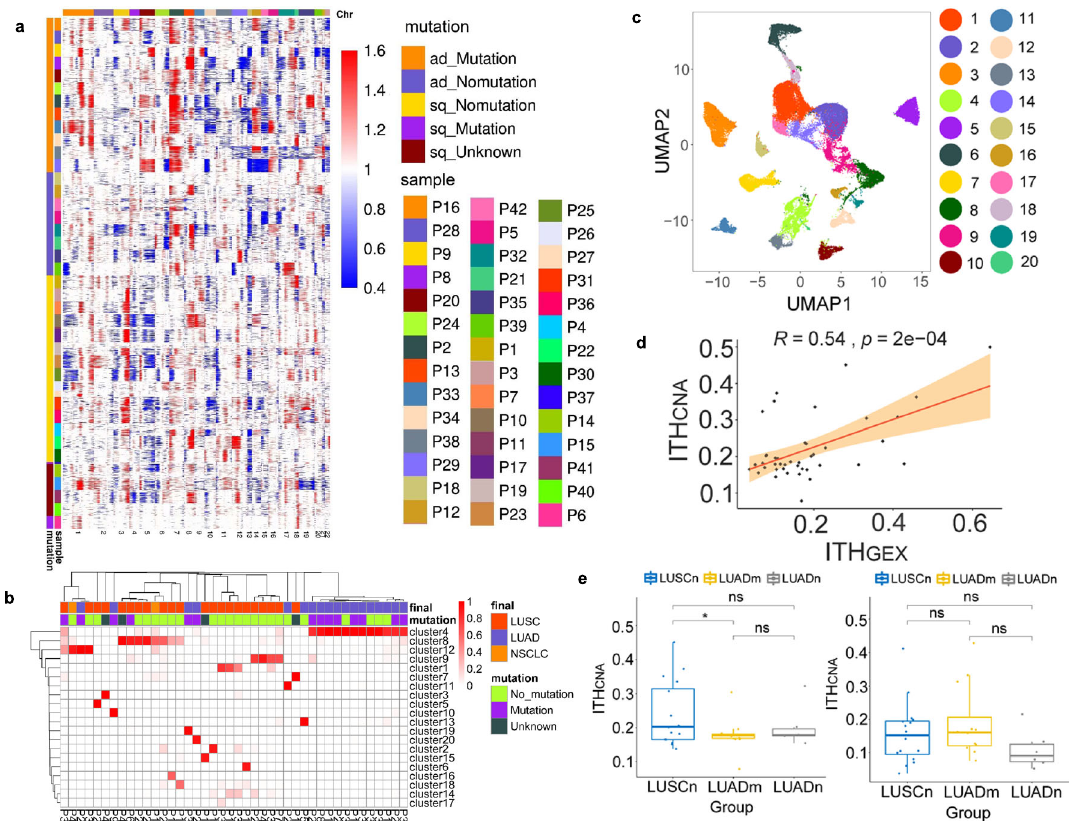
Fig. 2 Inter- and intratumor heterogeneity of cancer cells. a Heatmap of CNA pro fi les inferred from scRNA-seq of tumor cells of patients. Red indicated genomic ampli fi cations and blue indicated genomic deletions. The x -axis showed all chromosomes in the numerical order. The y -axis was marked by both patient subgroups. b Heatmap displaying proportions of cancer cells of each patient in cancer clusters. The clustering results of cancer cells were generated using resolution 0.4 in Seurat. The arrangement of the patients on the y -axis were based on their similarities using hierarchical clustering. c UMAP visualization of cancer cell clusters. The cluster IDs corresponded to cluster IDs shown in b . d Correlation between ITH CNA and ITH GEX for 42 patients. Shaded areas corresponded to the 0.95 con fi dence interval analyzed by two-sided t -test. e Statistical tests of ITH CNA and ITH GEX between patients in different groups, LUSCn, LUADm and LUADn (LUSCn: n = 16, LUADn: n = 6, LUADm: n = 12 biological independent samples. * p ≤ 0.05; ns: p > 0.05). Two- sided unpaired Wilcoxon test was performed to compare between groups. The lower hinge, middle line, and upper hinger of boxplots represented the fi rst, second, and third quartiles of the distributions. The upper and lower whiskers corresponded to the largest and smallest data points within the 1.5 interquartile range. All actual data values were also plotted as dots alongside the